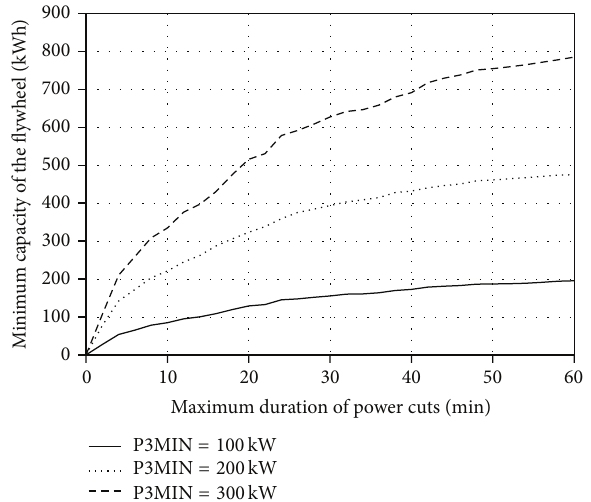
= 𝑓(𝑇 ) for Enercon ESMIN MAX